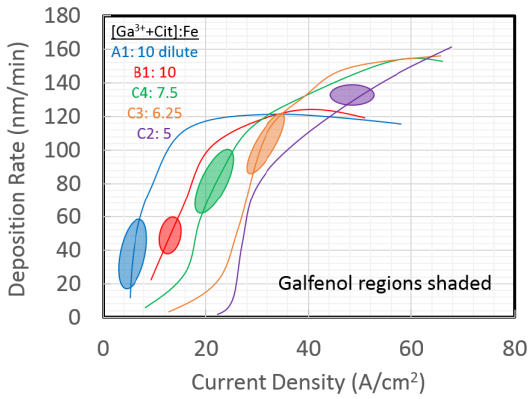
Figure 2. Electrochemical phase diagram showing the regions of ion ratios and current densities that produce Galfenol or other phases. Electrolyte ion concentrations are shown in the legend [11].